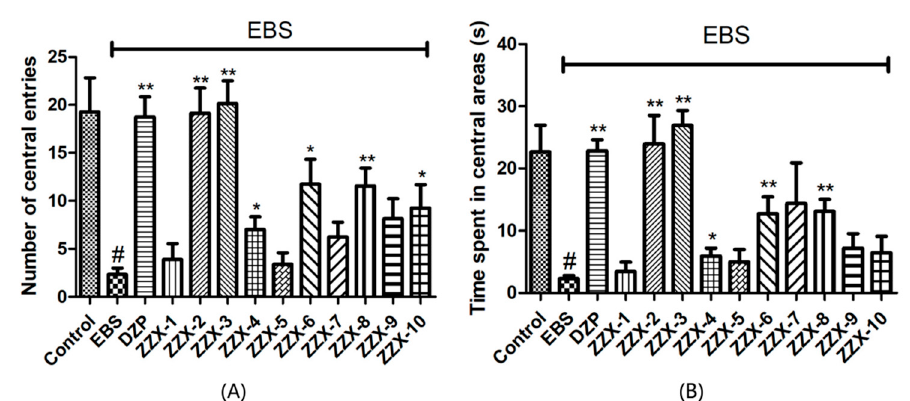
Figure 3. Effect of ZZX on the number of central entries and time spent in central areas in the open-field test in EBS rats. ( A ) Number of central entries; ( B ) time spent in central areas (s). Bars represent mean ± SEM. # represent p < 0.05 compared to control group; * represent p < 0.05 compared to EBS/ZZX group; ** represent p < 0.01 compared to EBS/ZZX group. One-way ANOVA with Student-Newman-Keuls post hoc test.